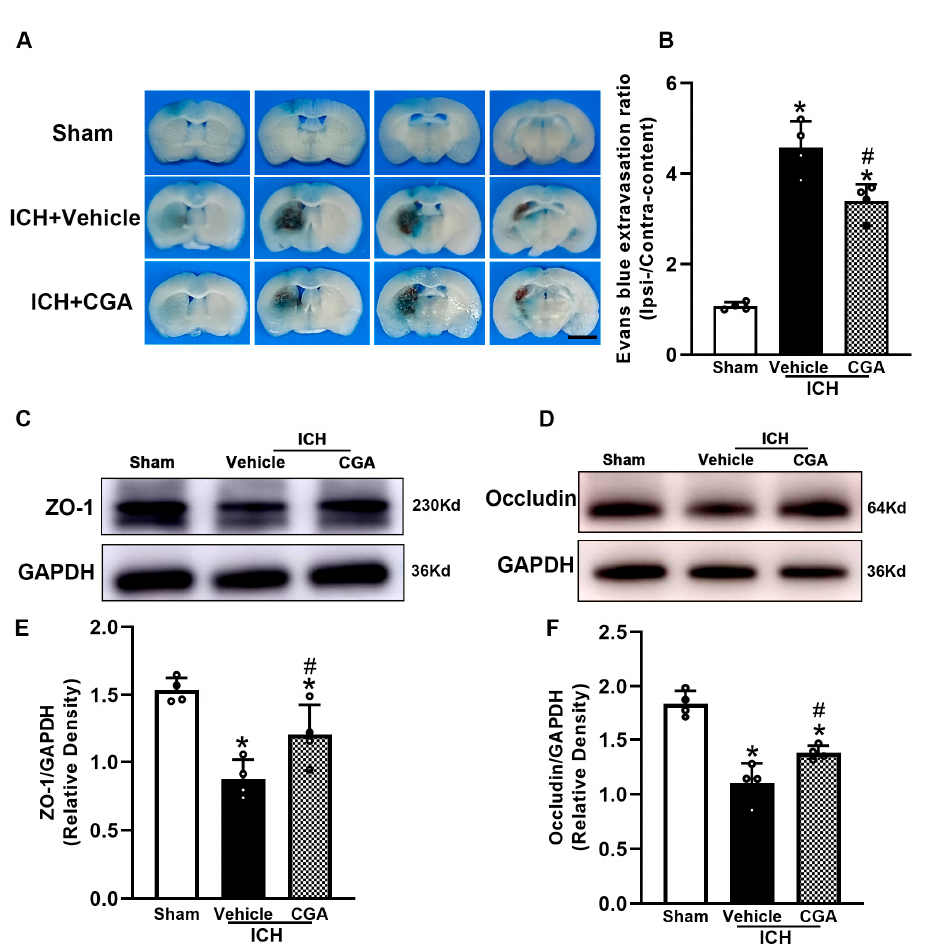
Figure 4. CGA reduces blood–brain barrier permeability in mice subjected to ICH. ( A ) The morphol- ogy of brain tissue is shown to observe the effects of CGA on reduction of Evans blue dye leakage at 3 days after ICH, scale bar = 2.5 mm. ( B ) The bar graph indicates that CGA diminishes Evans blue extravasation. ( C , D ) Western blotting was performed to detect protein levels of ZO-1 and occludin. CGA reduces the expression of ZO-1 and occludin at 3 days after ICH. ( E , F ) The bar graph indicates the density of ZO-1 and occludin versus GAPDH in different groups. * p < 0.05 vs. sham; # p < 0.05 vs. ICH + vehicle group. Data are presented as mean ± SD; n = 4 for each group.